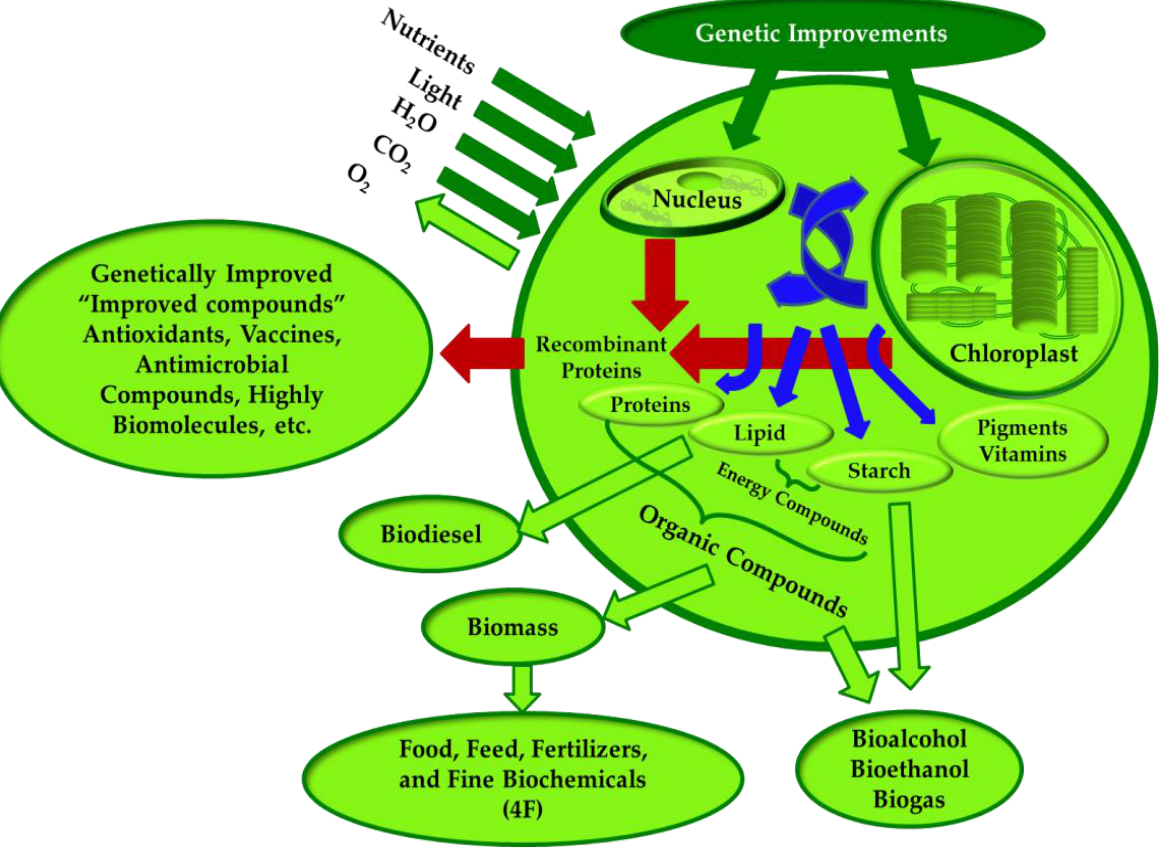
Figure 2. Scheme of the natural processes in microalgae genetic